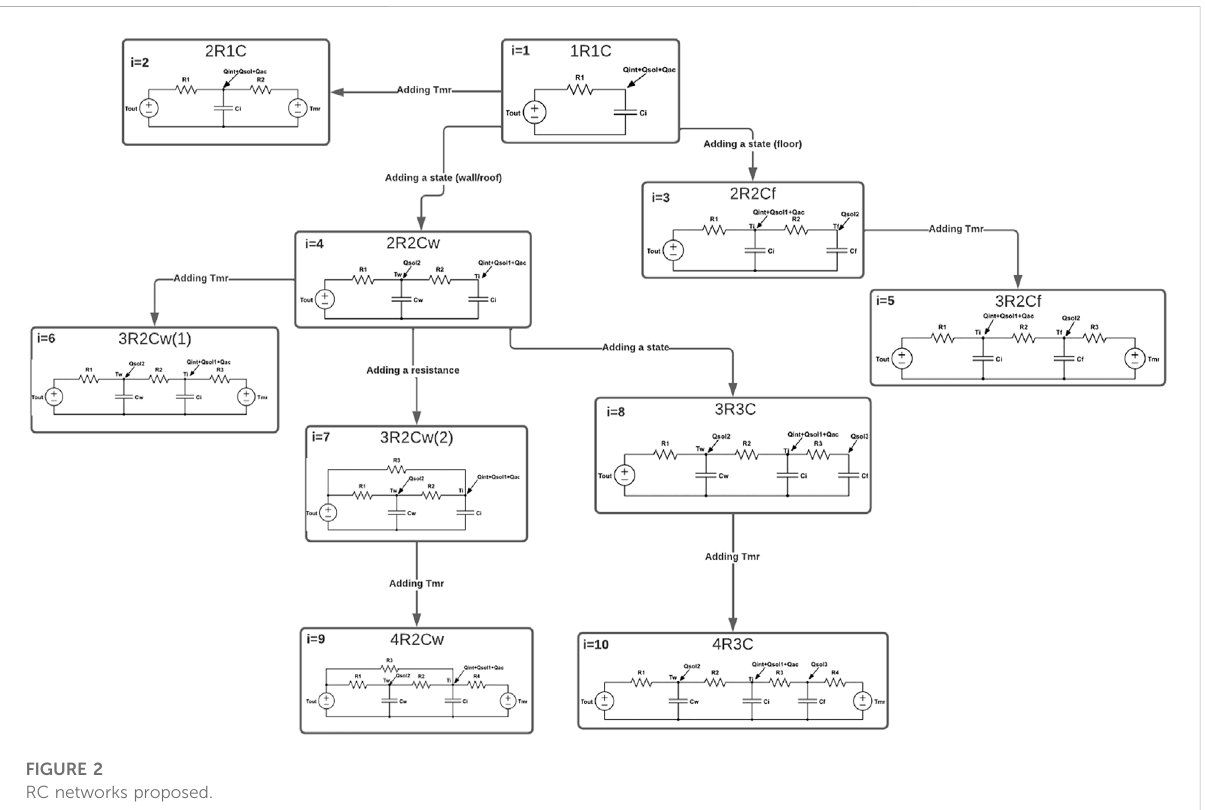
FIGURE 2 RC networks